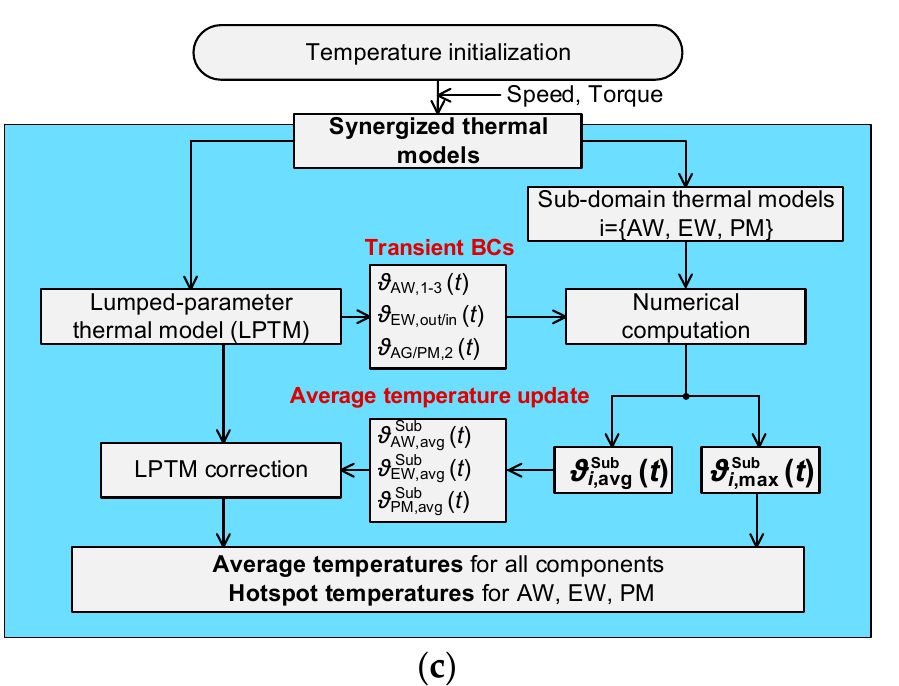
Figure 36. Synergized white-box thermal model for hotspots tracking based on a 12-slot/10-pole prototype SPMSM [85]. ( a ) Synergized white-box thermal model. ( b ) Cross-section of prototype SPMSM. ( c ) Flowchart of synergised thermal model.